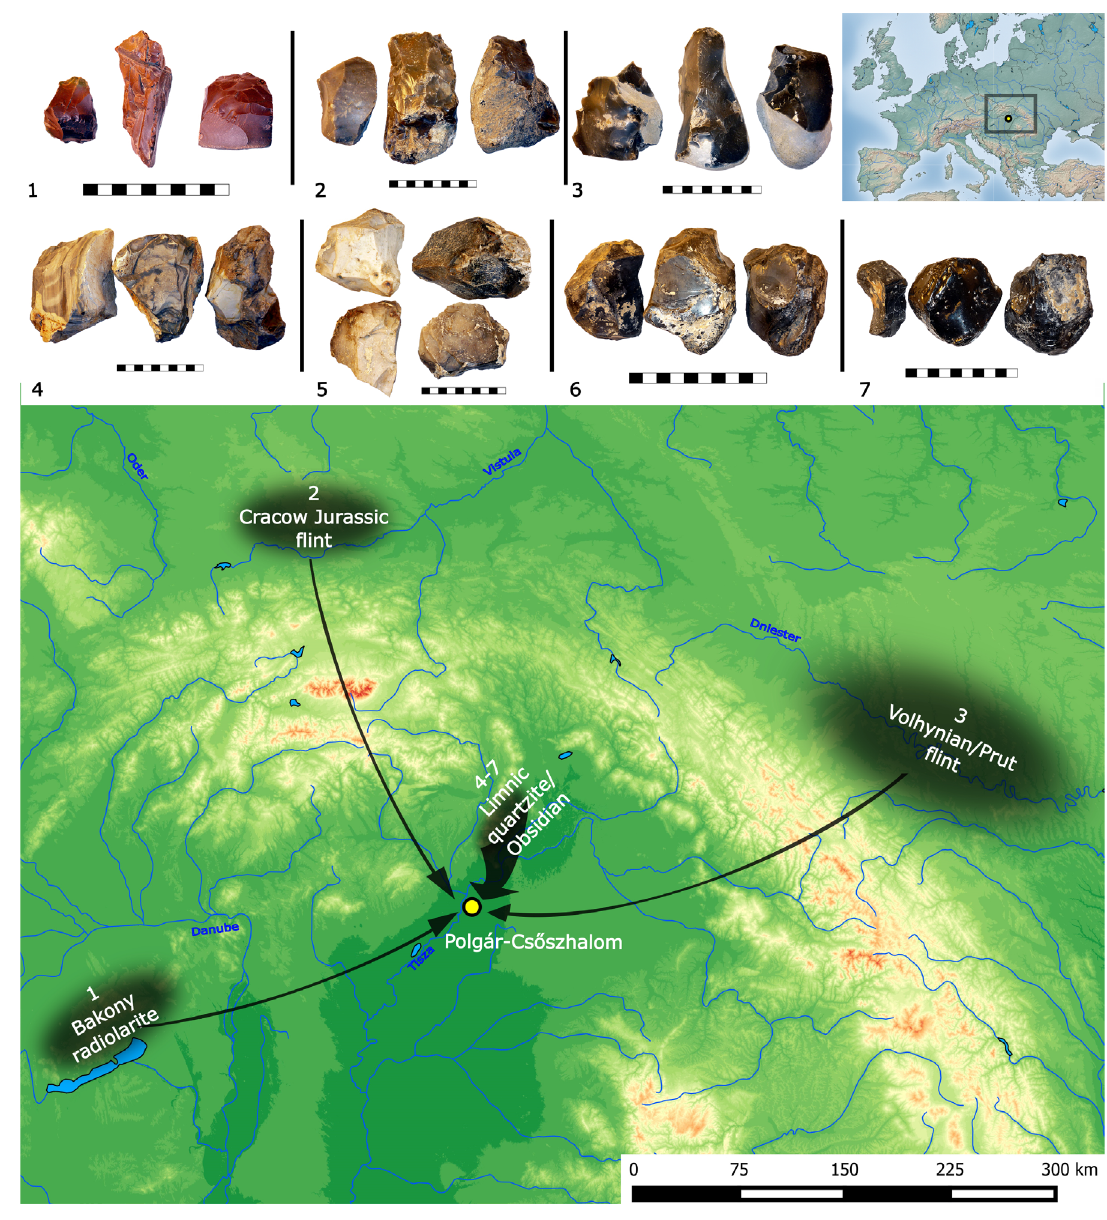
Figure 2: The raw materials and their distances from the site. Another part of the assemblage also originated in the Tokaj Mountains; however, its genesis is a little bit different. The Carpathian obsidian is a product of the same period and same geologic processes—namely, tertiary volcanism. Its formation is connected to volcanic activity by the fast solidification of the rhyolite lava, together with a very quick loss of heat and water containment without any crystallization (Gyarmati and Szepesi 2007, 28.). Within the literature, there are two subtypes in the Tokaj Mountains: one is from the Slovakian part of the region and it is more translucent; the other, from the Hungarian part, is more opaque and sometimes grey banded (Biró 1998, 33). The different characters of their cortex also aids in their identification— while the former has rough surface, the latter is plainer and finer. Both subtypes appear in Polgár-Csőszhalom, with 1,351 examples cumulatively weighing 6,113 grams. Another raw material type can be found at a similar distance from the site, but in a different direction. The quartz porphyry is from the eastern side of the Bükk Mountains, namely in the region of